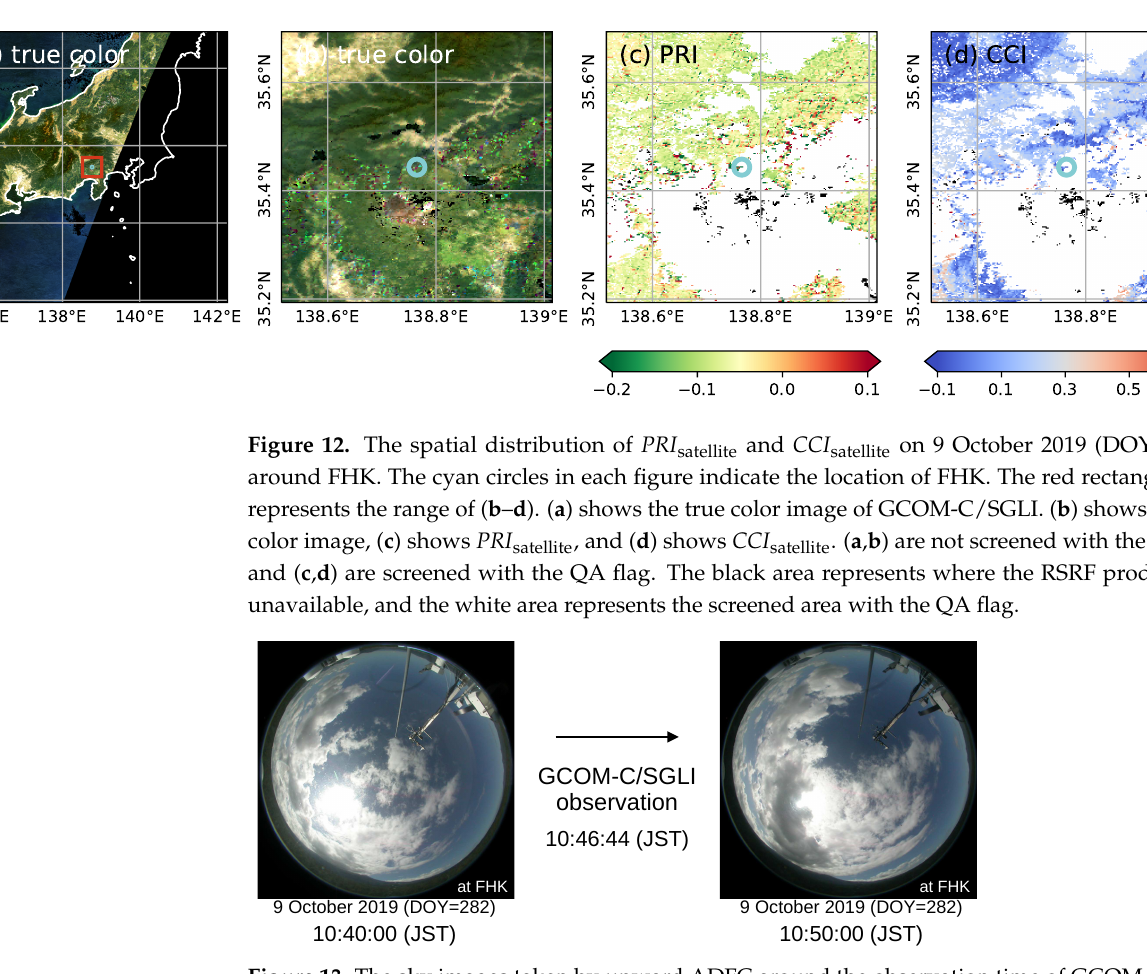
Figure 13. The sky images taken by upward ADFC around the observation time of GCOM-C/SGLI (10:46:44 (JST)) at FHK on 9 October 2019 (DOY =